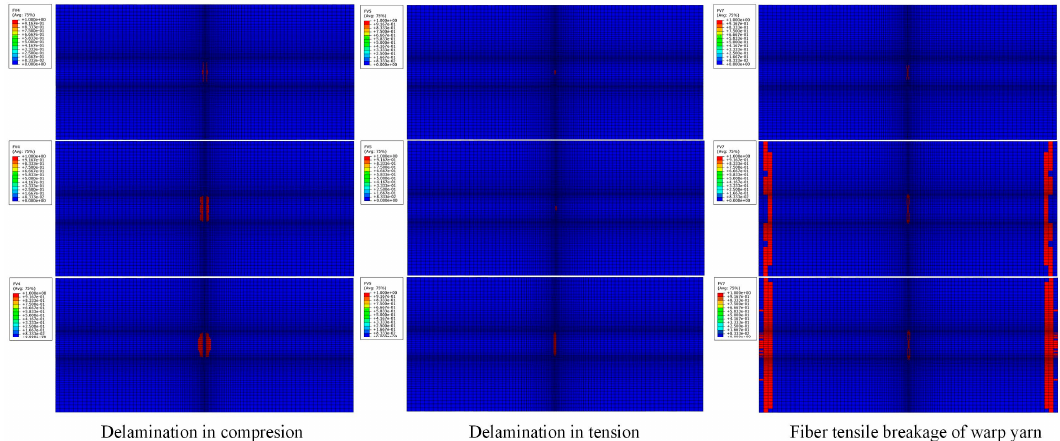
Figure 13. Failure modes and damage propagation in the GFRP patch.